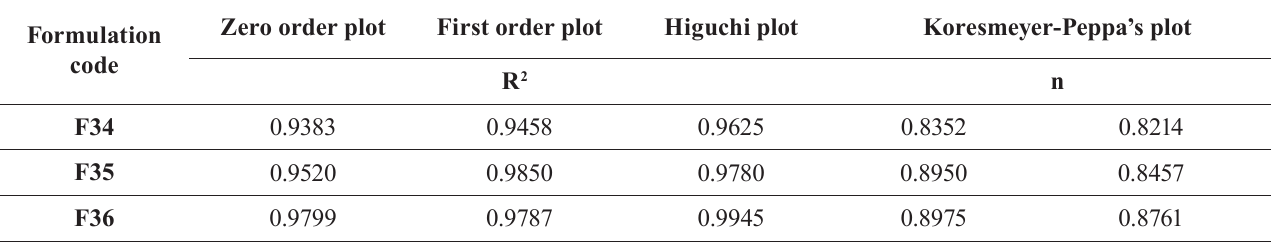
TABLE VII - In-vitro dissolution kinetics data of inclusion complex of selected formulations